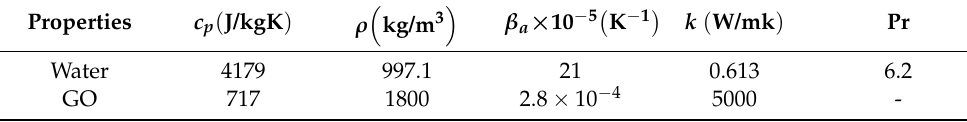
Table 1. The thermo-physical properties of the water/GO nanofluid [22].